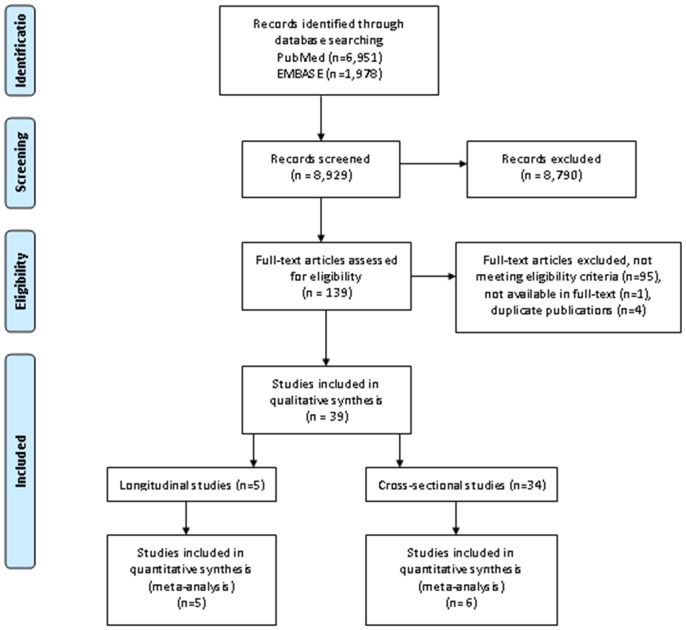
flow diagram of study inclusion.